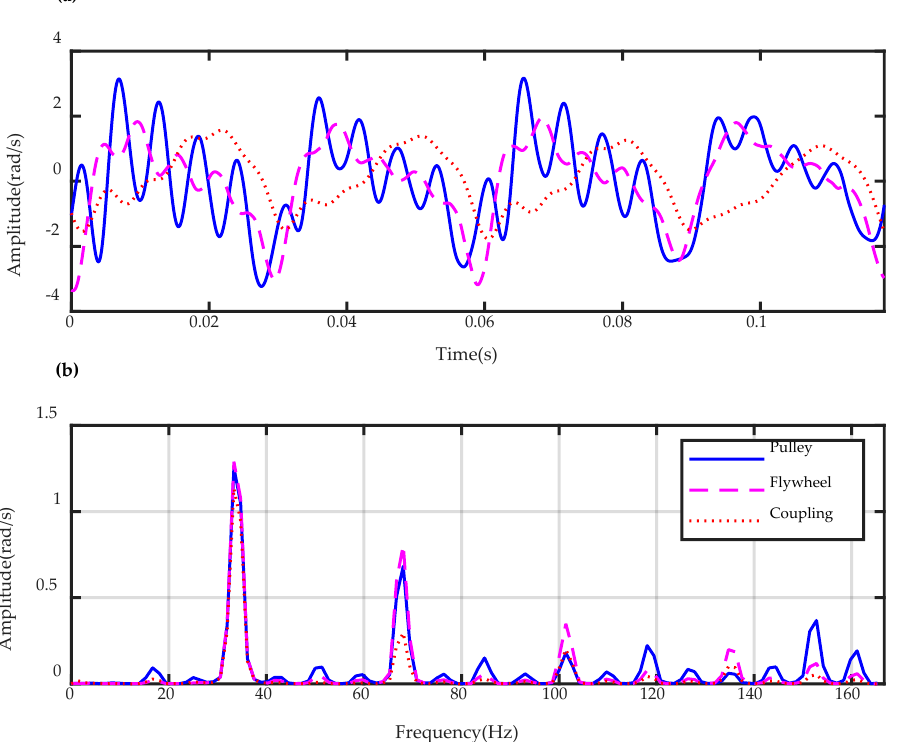
Figure 8. IAS values of the pulley, flywheel and coupling: ( a ) in the angular domain; ( b ) in the frequency domain.